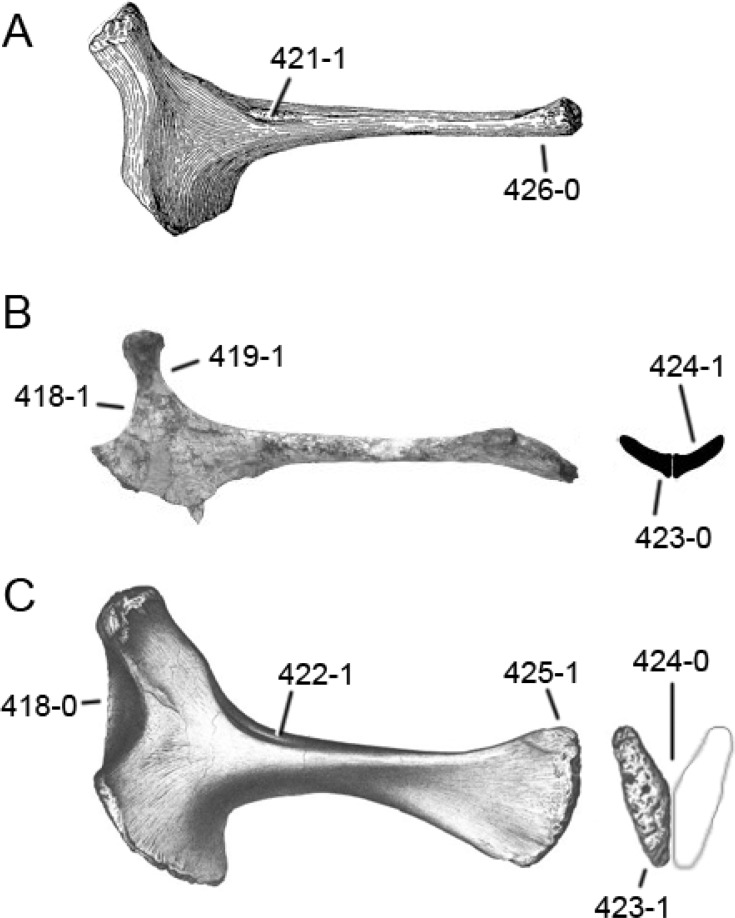
Diplodocoid ischia.Left ischium of Haplocanthosaurus priscus CM 572 (A; modified from Hatcher, 1903), Demandasaurus darwini MPS-RVII,18 (B; modified from Pereda Suberbiola et al., 2003), and Brontosaurus excelsus YPM 1980 (C; modified from Ostrom & McIntosh, 1966) in lateral (left) and distal (right) view. Note the flat (C; C418-0) in contrast to strongly concave acetabular margin (B; C418-1), the constricted neck of the iliac tubercle (B; C419-1), the elongate muscle scar on the proximal shaft (A; C421-1), the lateral fossa at the base of the blade (C; C422-1), the blade-like (B; C423-0) or medially expanded distal ends (C; C423-1), which form a more or less straight line (B; C424-1) or a V (C; C424-0), and can be straight (A; C426-0) or expanded dorsoventrally as well as transversely (C; C425-1). The light gray line in B indicates the distal view of the right ischium. Scaled to same length.